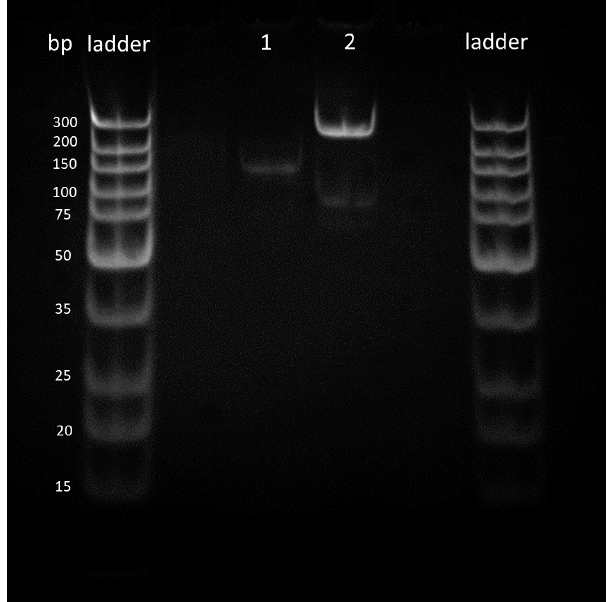
Figure 5. Singleplex solid-phase RPA reactions. Results showed successful amplification of both Gram-negative (2) and Gram-positive bacteria (1).